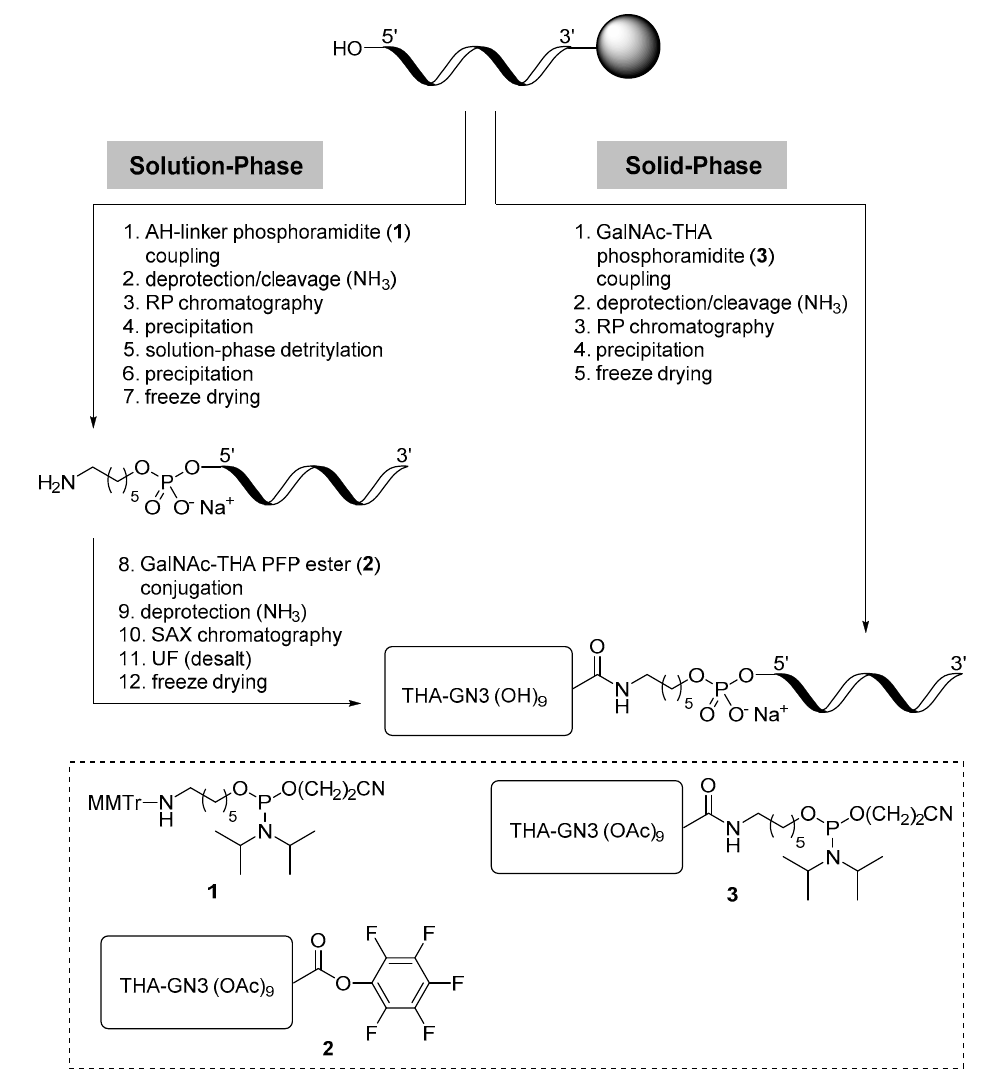
Figure 2. Solution-phase and solid-phase conjugation approaches.